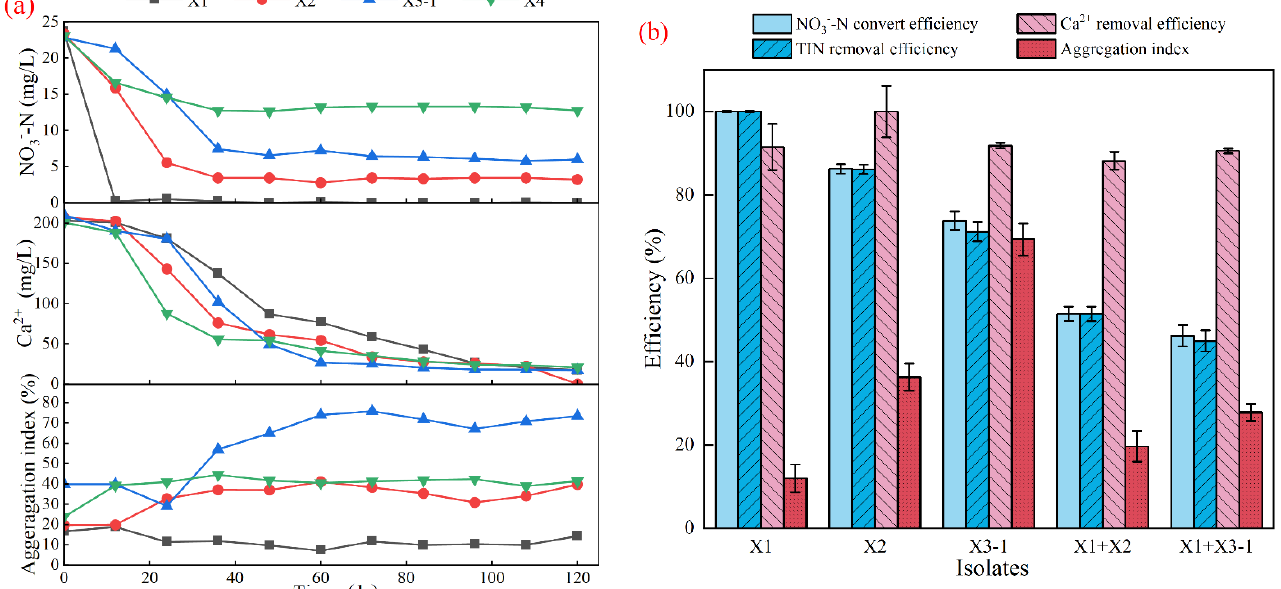
Figure 1. ( a ) Performance of strain X1, X2, X3-1, and X4; ( b ) NO 3 − -N convert efficiency, TIN removal efficiency, Ca 2+ removal efficiency, and aggregation index of X1, X2, X3-1, X1 + X2, and X1 + X3-1.